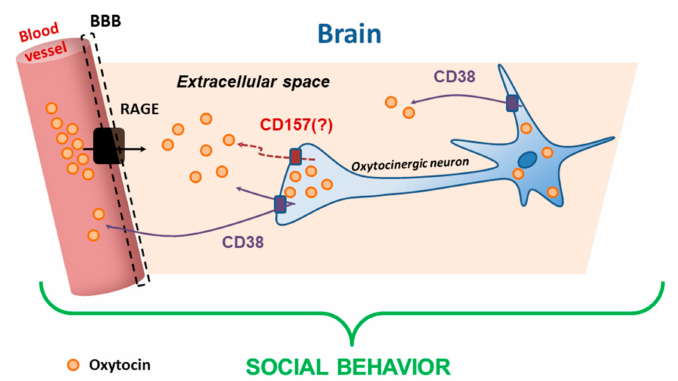
Figure 6. Scheme of the recruitment of OT in the brain extracellular space. OT in the blood is transported by RAGE on the endothelial cells of the blood–brain barrier (BBB). The OT in oxytocinergic neurons is secreted into the extracellular space via CD38 or CD157 from dendrites and axon collaterals. At the axon terminals, OT is released into the portal vein at the posterior pituitary. The turnover of OT may be a basis of social